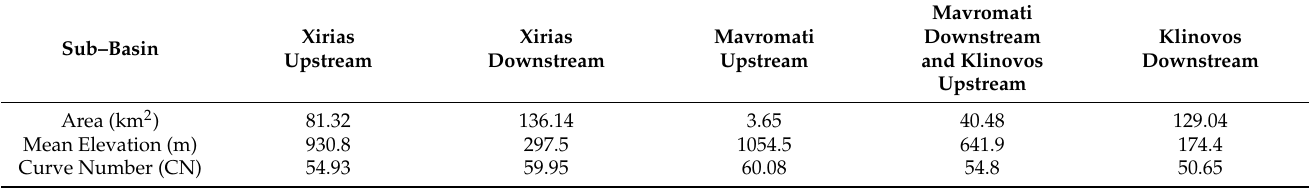
Table 1. Characteristics of sub-watershed areas contributing to the inflows of the